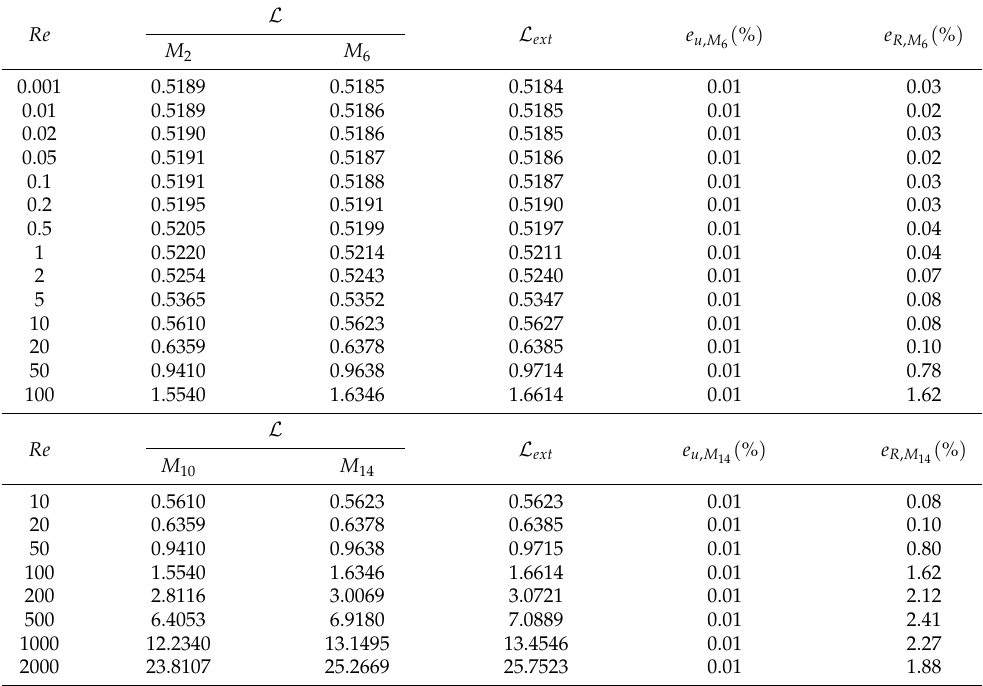
Table A2. Mesh accuracy tests and development lengths for AR = 0.25.